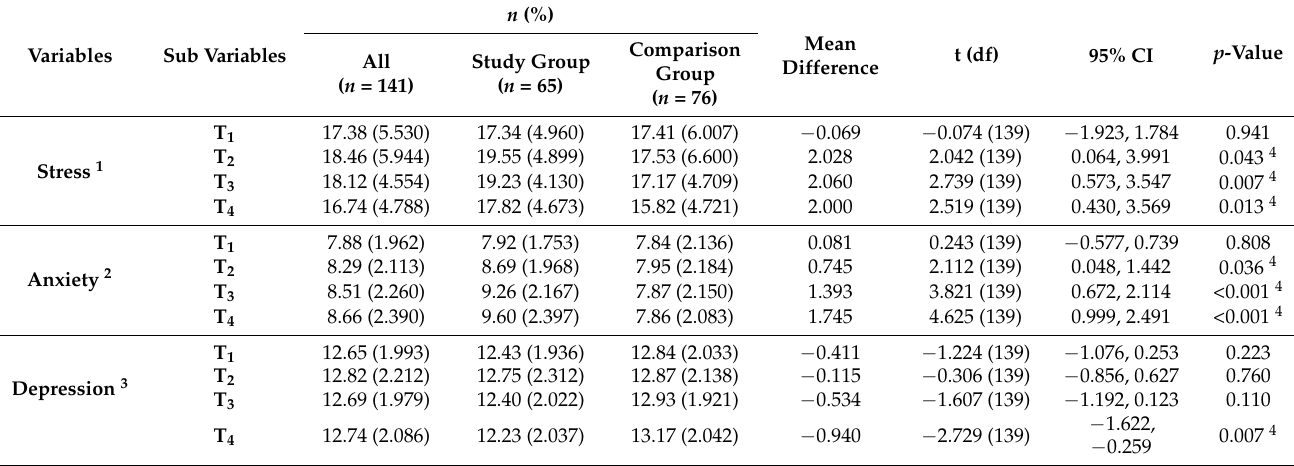
Table 3. Participants’ mental health profile ( n =